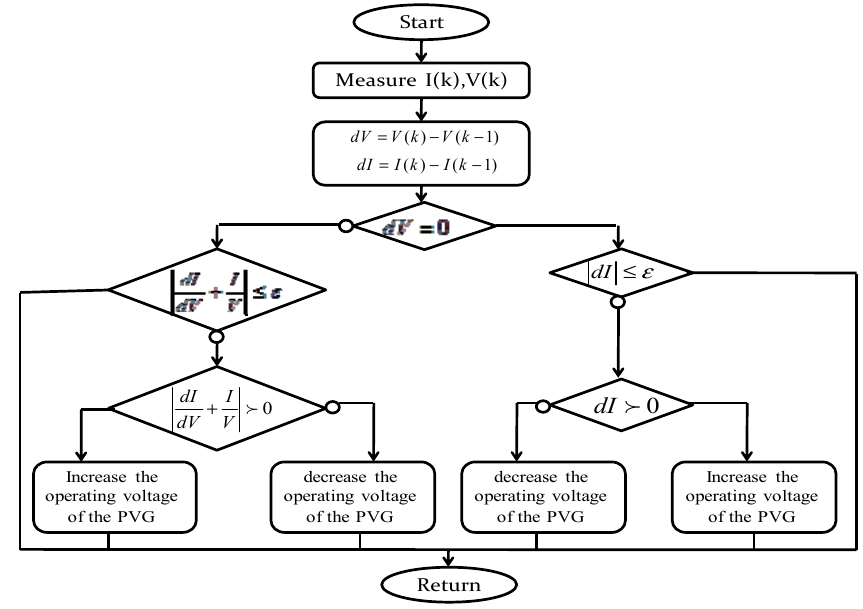
Figure 4. Flowchart of the used InC MPPT based algorithm.